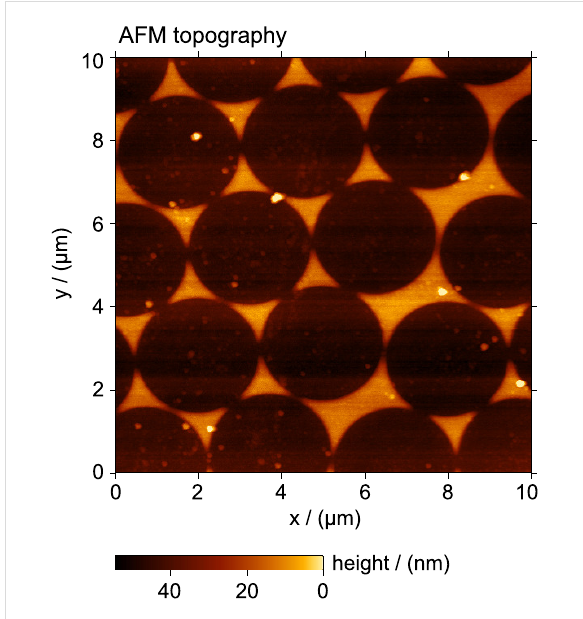
Figure 5: Topography image of a projection pattern of Cr on quartz. The height of the pattern is 30 nm. Small particles scattered on the surface are chemical species that were not completely removed during the spheres lift-off.